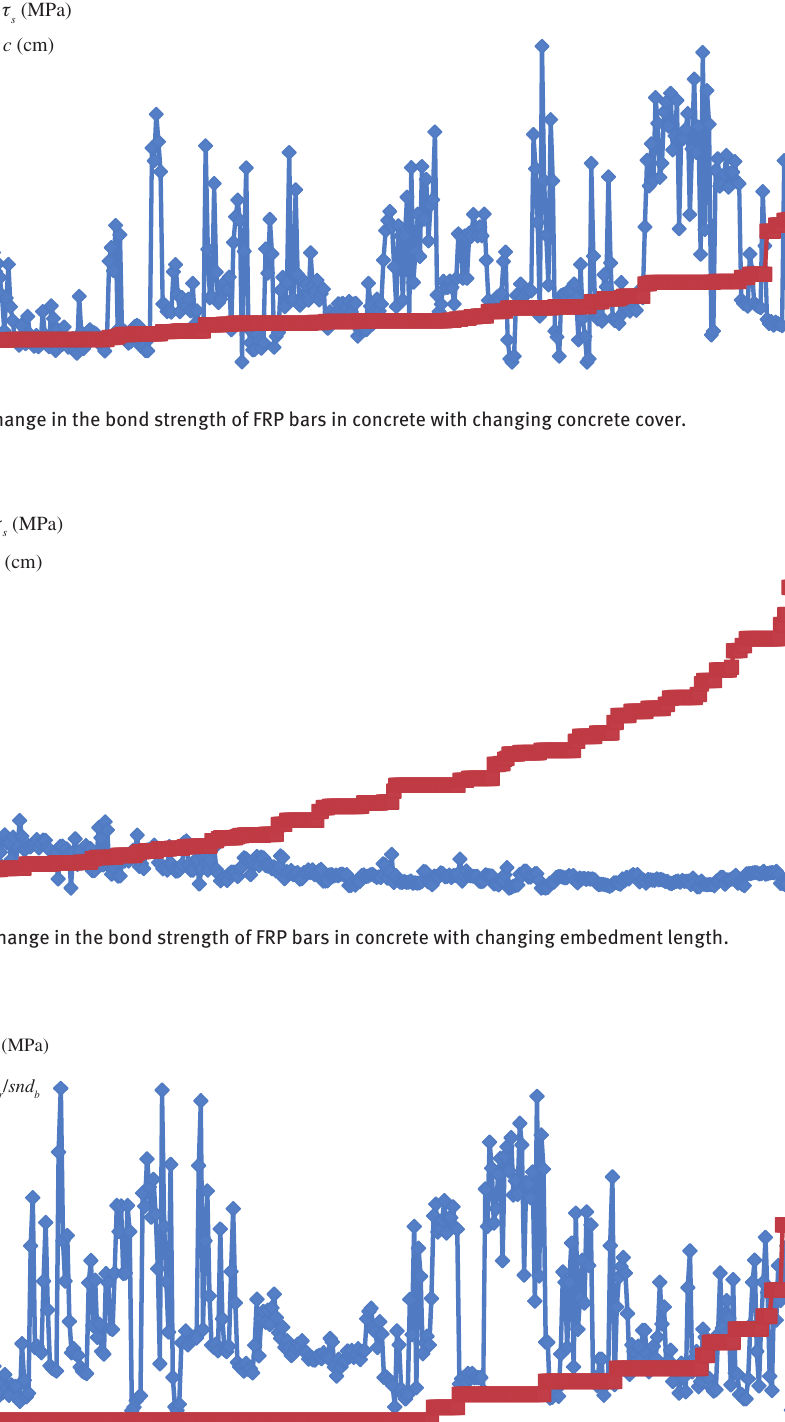
and bar location are taken into account for all methods The bond strength of FRP bars to concrete calcu- except the regression model, which considers only con- lated using different design specifications is illustrated in crete strength, bar diameter, embedment length and bar Table 4. Concrete strength, bar diameter, concrete cover